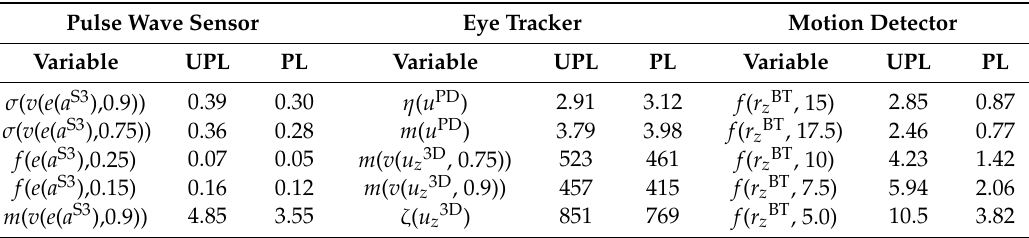
Figure 13. The accuracy of personalized model of pleasant emotion. Table 8. Top five of the important variables for predicting the pleasant emotion in the personalized model.